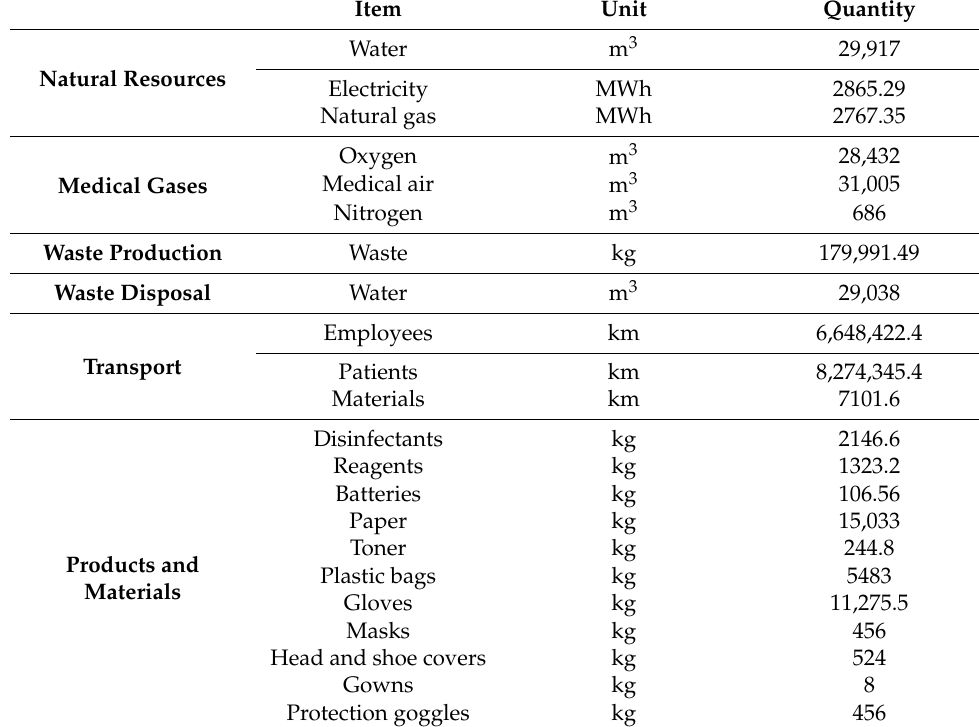
Table 1. Life cycle inventory associated with the activities and services provided by the hospital in